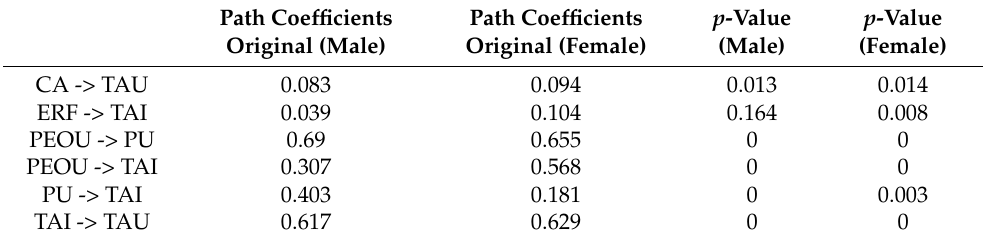
Table 5. Bootstrapping outcomes.